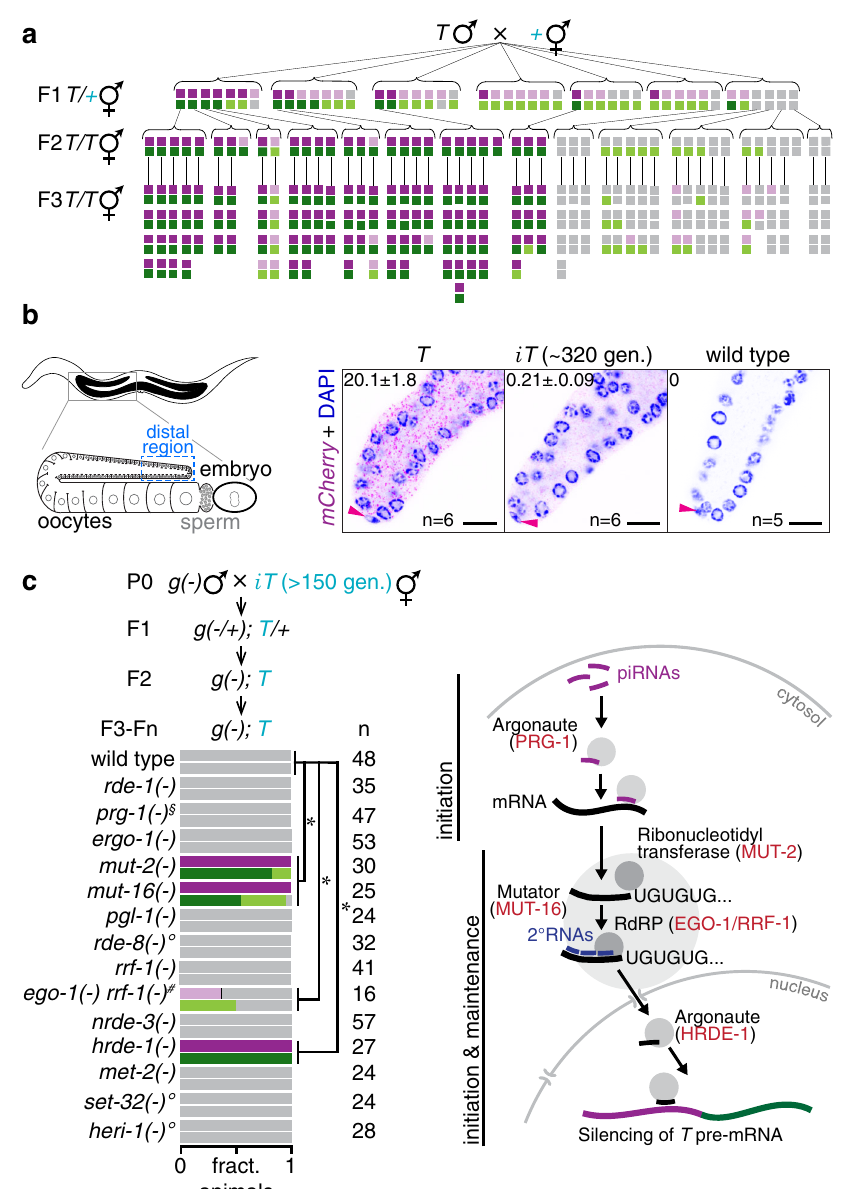
Fig. 3 Mating-induced silencing is actively maintained for >300 generations. a Mating-induced silencing was initiated and silencing was scored in cross progeny and their descendants. Each vertical pair of boxes represents fl uorescence intensity of mCherry and GFP within the same animal (bright, dim, and off, as in Fig. 1c). b Maintenance of mating-induced silencing was measured by smFISH against mCherry exonic RNA in indicated distal region of dissected gonads of adult T , iT (silenced for ~320 generations) or wild-type animals. Pink arrowheads indicate the nucleus of the distal tip cell. Animals with median values of fl uorescence or RNA signal in the distal region are shown in representative images. smFISH probes used are depicted in Supplementary Fig. 2d. Merged (DAPI + mCherry RNA smFISH) images shown here are also shown in Supplementary Fig. 6a as separate channels with remaining images from the same animals. Numbers within images indicate number of RNAs per 100 µ m 2 with standard error of the mean. c Left, iT hermaphrodites that showed 150 – 250 generations of continued silencing were crossed with males mutant for RNAi genes ( g(-) ) and resulting descendants homozygous for the mutant allele of the gene were scored at F3 ( rde-1(-) , prg-1(-) , rrf-1 (-) , ego-1(-) rrf-1(-) , nrde-3(-) , hrde-1(-) ), F4 ( ergo-1(-) , heri-1(-) ), F5 ( pgl-1(-) , rde-3/mut-2(-) , mut-16(-) , set-32(-) ), ~F15 ( rde-8(-) ) generations, or scored at F4/F6/F8 and pooled ( met-2(-) ). Use of prg-1( − / + ) parent males owing to the poor mating by prg-1(-) parent males is indicated (§). Use of fertile ego-1( − / + ) rrf-1( − / − ) parent hermaphrodites, rather than sterile ego-1(-) rrf-1(-) parent hermaphrodites, mated to iT males is indicated (#). Use of Cas9-mediated genome editing rather than genetic cross to introduce mutation is indicated (°). Right, Model of piRNA-mediated RNA silencing (see text for details). Scoring of silencing ( a , c ) is as in Fig. 1c. Chromosomes with a dpy marker (blue font), number ( n ) of animals scored ( c ) or imaged by confocal microscopy ( b ) and scale bar (10 µ m) are indicated. Also see Supplementary Figs. 5 and 6. Asterisks indicate P <0.05 using χ 2 test ( c ). Also see ‘ Genetic Crosses ’ under Methods. Source data are provided as a Source Data fi